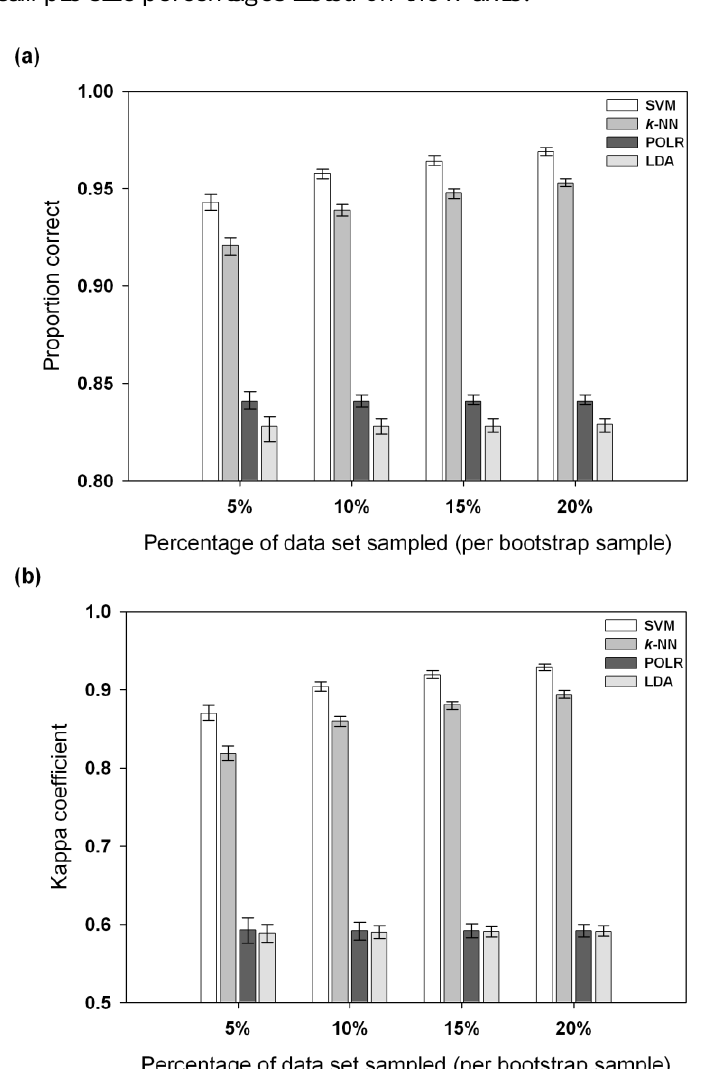
Figure 4. Results of the bootstrap resampling analyses. (a) Proportion correct and (b) kappa coefficient values for the support vector machine (SVM), k -nearest neighbor ( k -NN), proportional odds logistic regression (POLR), and linear discriminant analysis (LDA) classifiers. Bar heights represent mean values, and error bars indicate 95% confidence intervals obtained from resampling analyses using n = 1,000 bootstrap samples for each of the sample size percentages listed on the